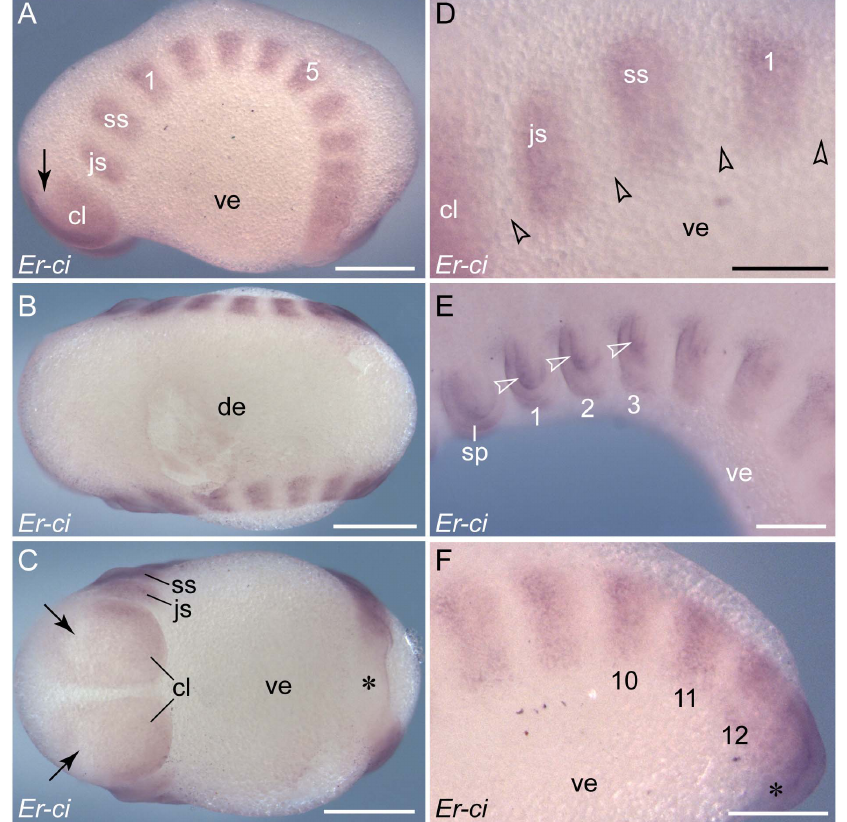
Figure 6. Expression of cubitus interruptus in embryos of E. rowelli . Anterior is left in all images. Leg- bearing segments and corresponding limbs are numbered. (A–C) Stage II embryo in lateral, dorsal and ventral views. Note the continuous belt of expression on each side of the body at the posterior end, which dissolves into nearly rectangular domains towards the anterior end. Note also the expression-free areas in the cephalic lobes (arrows) and around the proctodaeum (asterisk). (D) Detail of the anterior-most expression domains in a stage II embryo in lateral view. Arrowheads point to wide gaps between the domains. (E) Anterior portion of a stage IV embryo in lateral view showing expression in the ectoderm and mesoderm (somite walls) of the limb anlagen (arrowheads). (F) Posterior end of the same embryo as in E. Note the remnant of the continuous belt of expression near the proctodaeum (asterisk), which dissolves into solitary domains towards the anterior end. Abbreviations: cl , cephalic lobe; de , dorsal extra-embryonic tissue; js , jaw segment; sp , embryonic slime papilla; ss , slime papilla segment; ve , ventral extra-embryonic tissue. Scale bars: 500 m m (A–C), 250 m m (D–